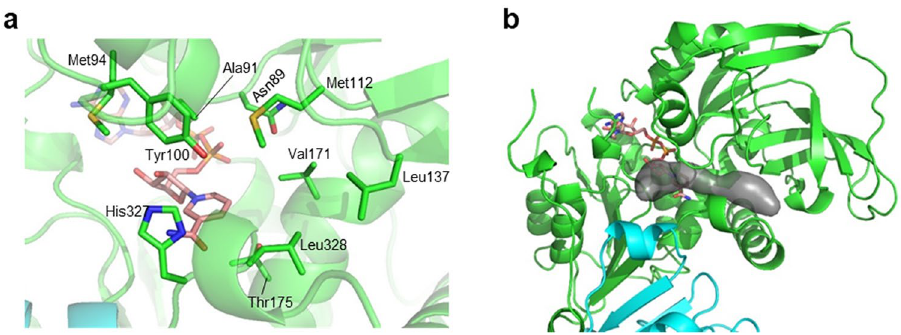
Figure 5. Putative substrate-binding site. ( a ) The putative substrate-binding site on the nicotinamide ring plane. ( b ) The cavity of the putative substrate-binding site is depicted as a gray